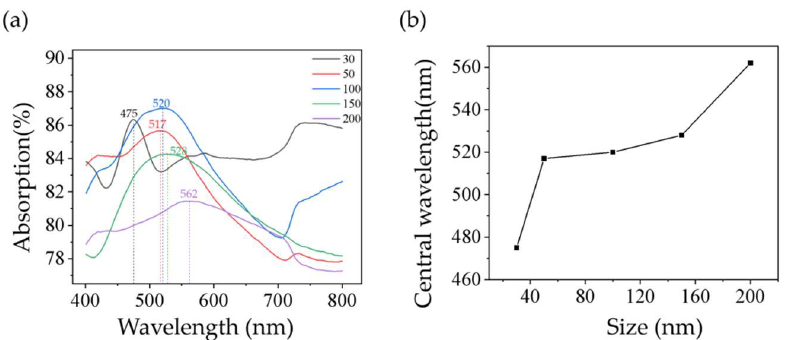
Figure 3. ( a ) Absorption spectra of samples Ag@SiO 2 ; ( b ) variation of the absorption peak wavelength with different Ag size (30, 50, 100, 150, and 200 nm).